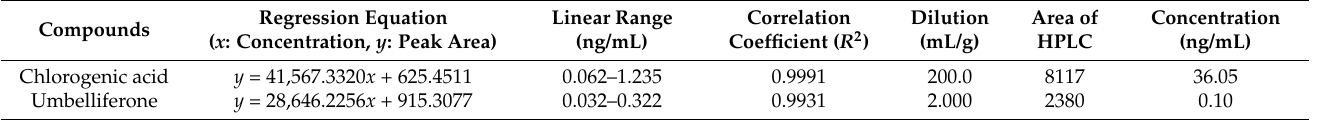
Table 2. Calibration curves and concentration of chlorogenic acid and umbelliferone.